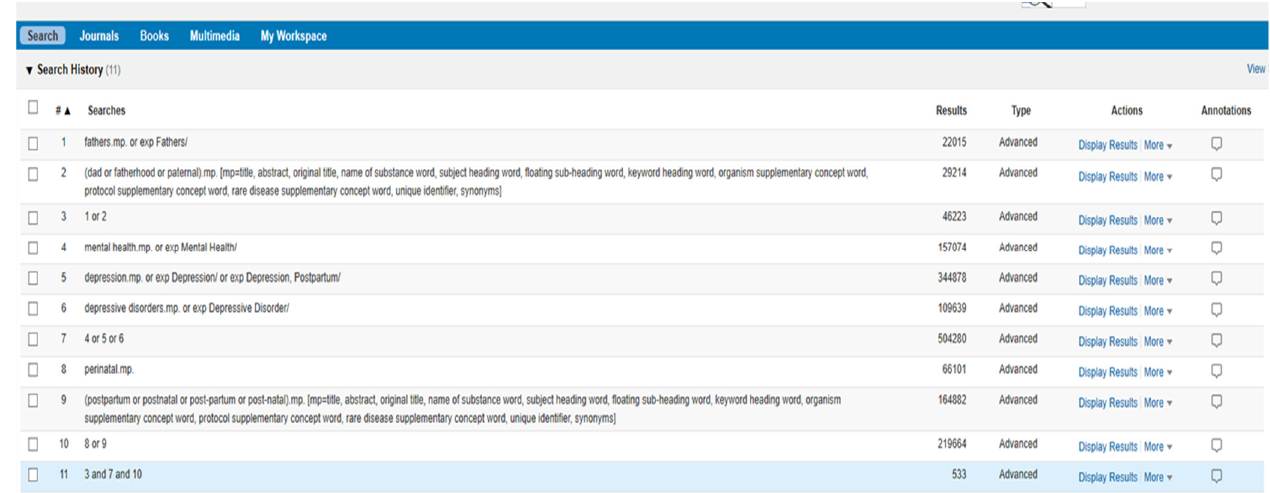
Figure 2. Draft electronic database search (Medline).